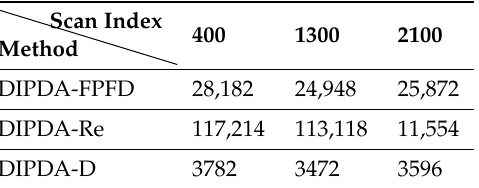
Table 5. Storage requirement of each compared method at different scans (take case 2 for example, l max = 10), storage requirement is evaluated by the stored number of